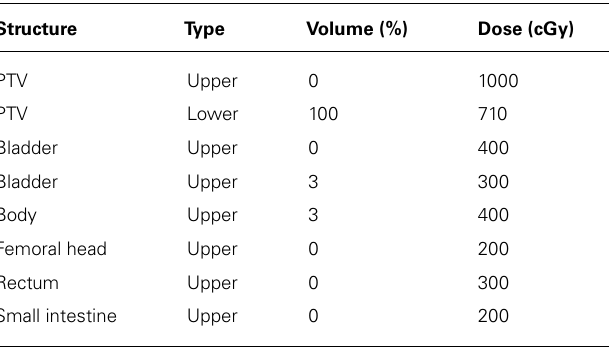
Table 1 | Dose constraints used for intensity-modulated radiotherapy and volumetric arc radiotherapy plans.